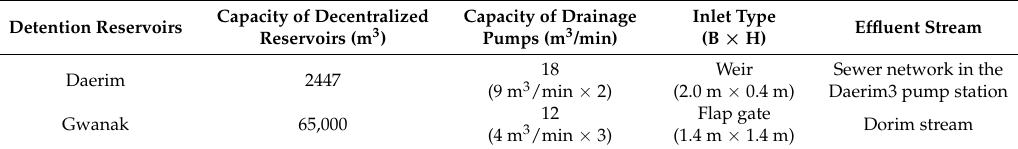
Table 5. Description of the detention reservoirs in the target watershed.